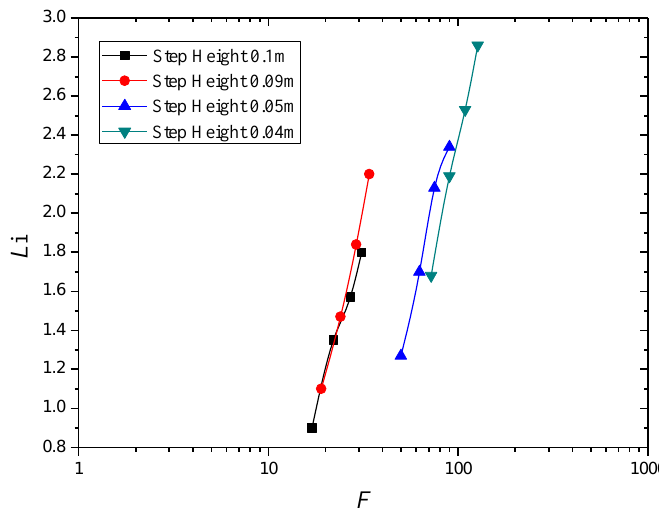
Figure 6. Variation of inception length ( Li ) with Froude surface roughness ( F ) at different stepped heights of flat stepped spillway models.